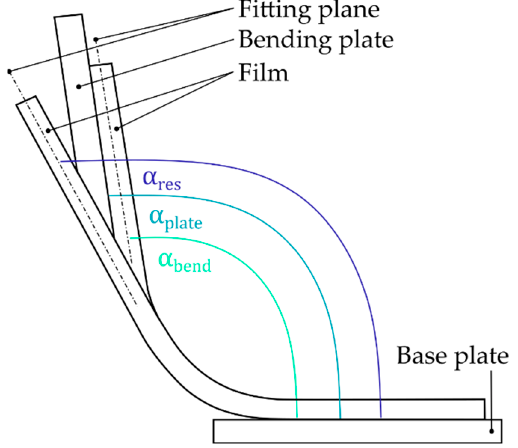
Figure 6. Illustration of the relevant angles for determining the forming ratio θ res of the film. In this context, the plate angle ( α plate ) refers to the angle that spans between the base plate and the bending plate in its final position within the bending process. Consequently, the bending angle ( α bend ) refers to the angle between the base plate and the film (fitting plane) at the same time the plate angle is determined. The resulting film angle ( α res ) corresponds to the angle between the base plate and the final position of the film (fitting plane) after the positioning plates (see Figure 3b) had been removed, the bending plate had been laid down, and the film had cooled off. The forming ratio θ res = α res / α bend was defined as the ratio of the resulting and the bending angle.